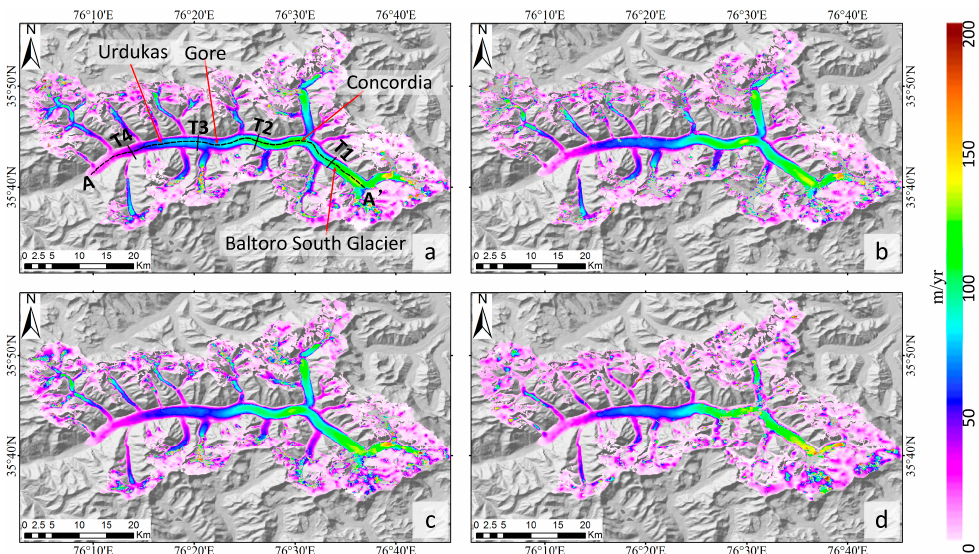
Figure 3. Four annual velocity fields of the Baltoro Glacier and its tributaries from 1999–2003. ( a ) 1999–2000; ( b ) 2000–2001; ( c ) 2001–2002; and ( d ) 2002–2003. The background is the hillshade image of SRTM DEM. AA’ is the centerline of the glacier and T1, T2, T3, and T4 are the transverse profile’s locations.